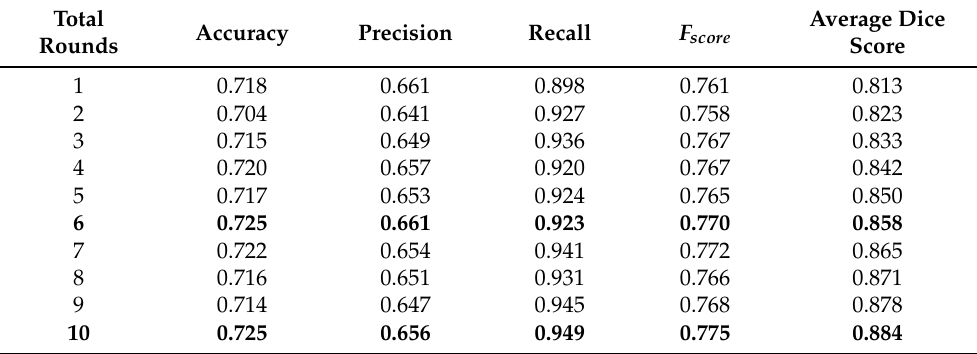
Table 7. Round-wise test results obtained from Raspberry Pi-centric transfer learning-based training. The best performance is highlighted in